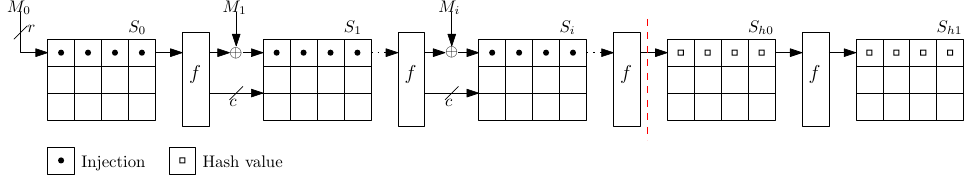
Figure 3: The process to compress the